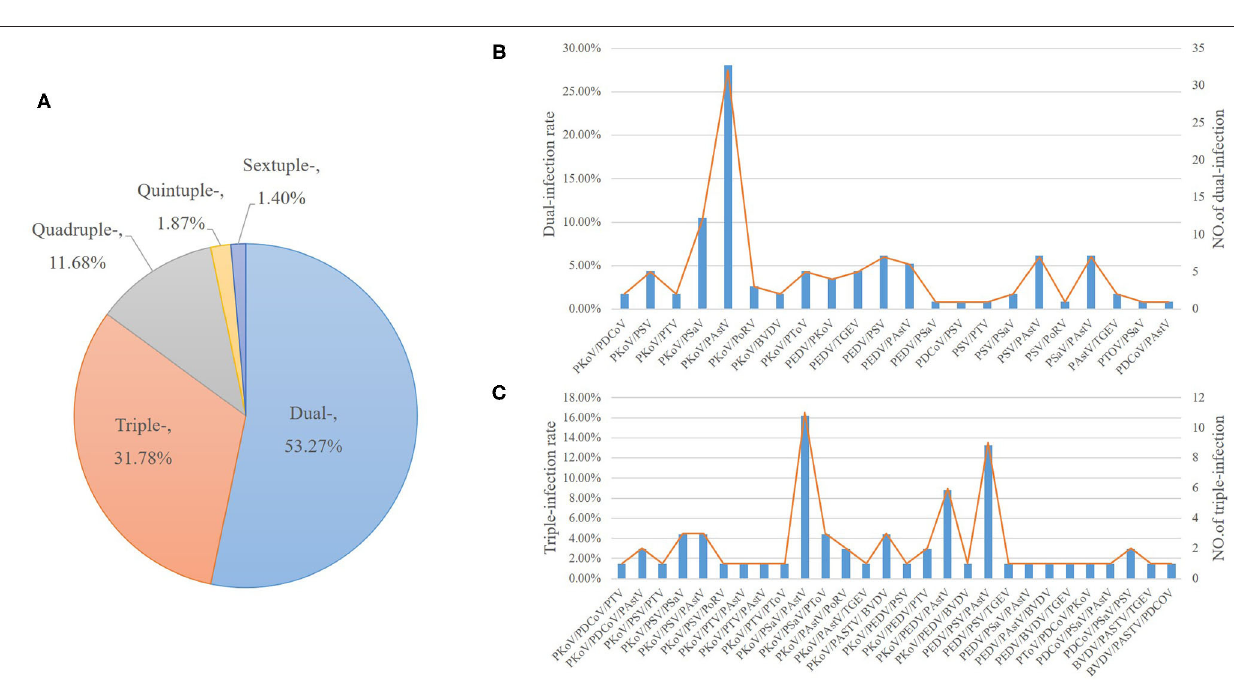
FIGURE 4 | The multiple infections of different enteric viruses. Various combinations of co-infections were identified. (A) The percent of multiple infections of different enteric viruses. (B) The positive percent (left Y axis) and positive numbers of dual-infections (right Y axis). (C) The positive percent (left Y axis) and positive numbers of